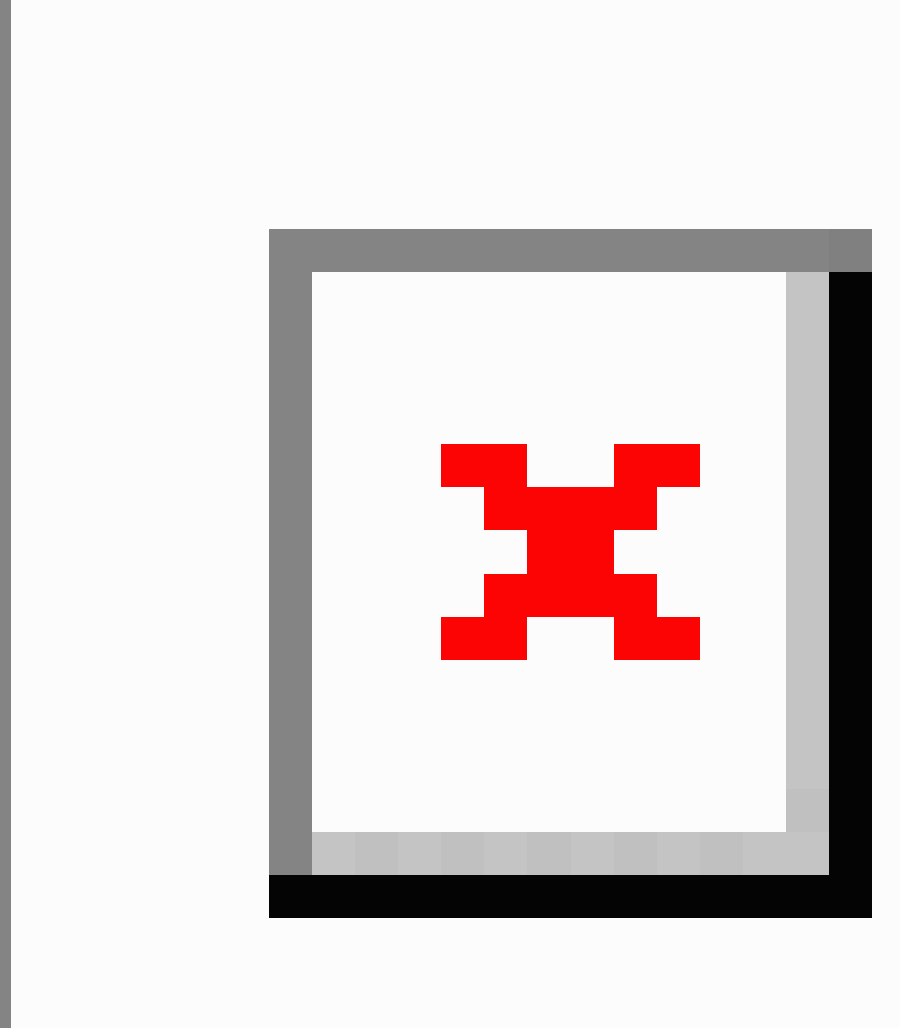
Figure 3. Results of model